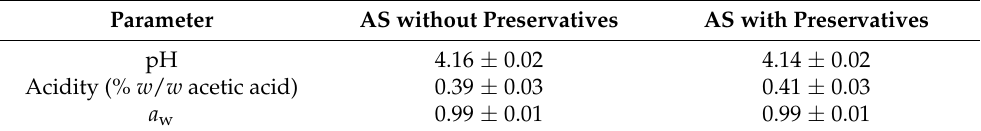
Table 2. Results of physicochemical parameters examined for AS with and without preservatives.